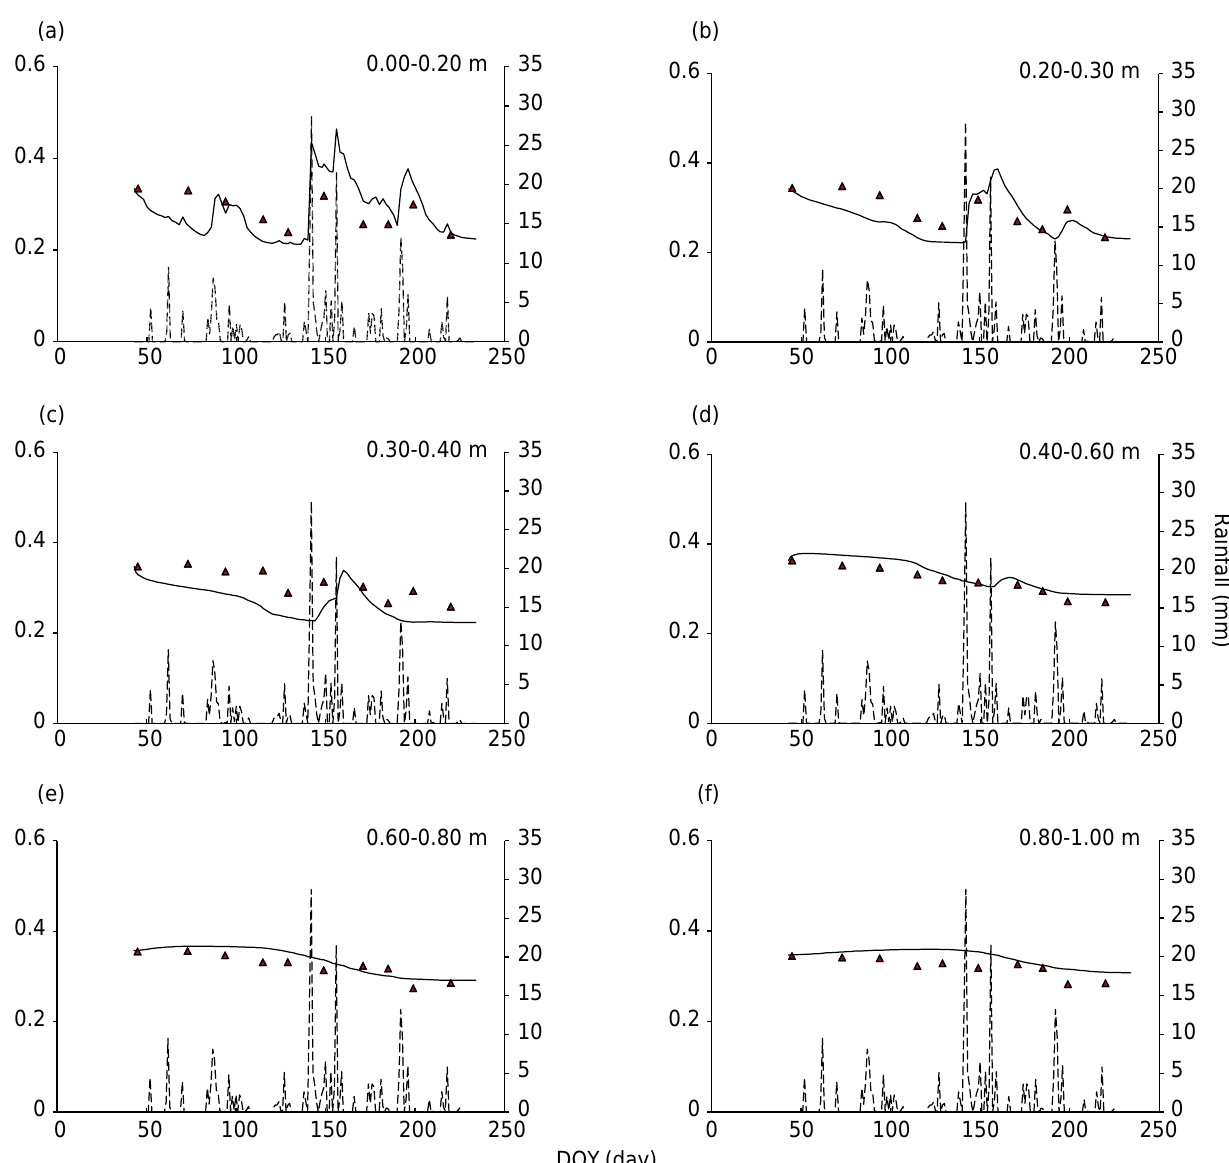
Figure 2. Comparison between the measured and simulated soil water contents in different layers (The dashed line stands for